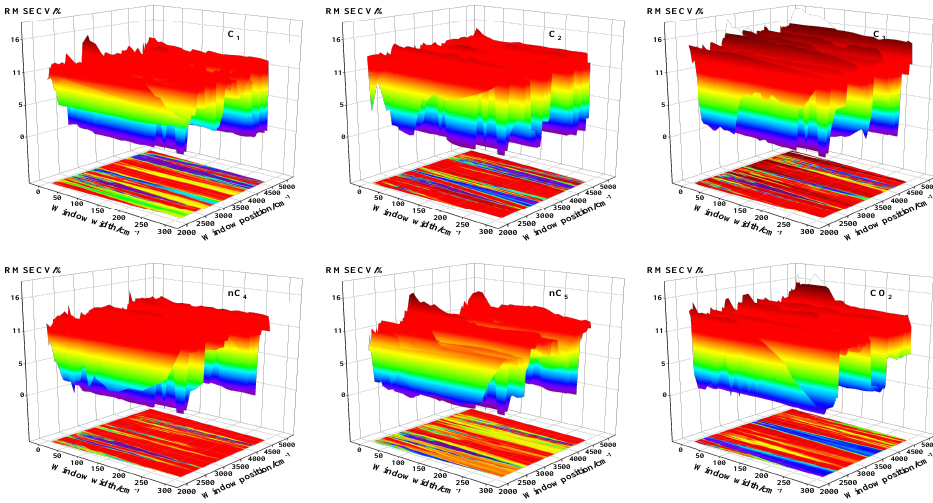
Figure 7. The accuracy of the local PLS model is affected by the width and position of the